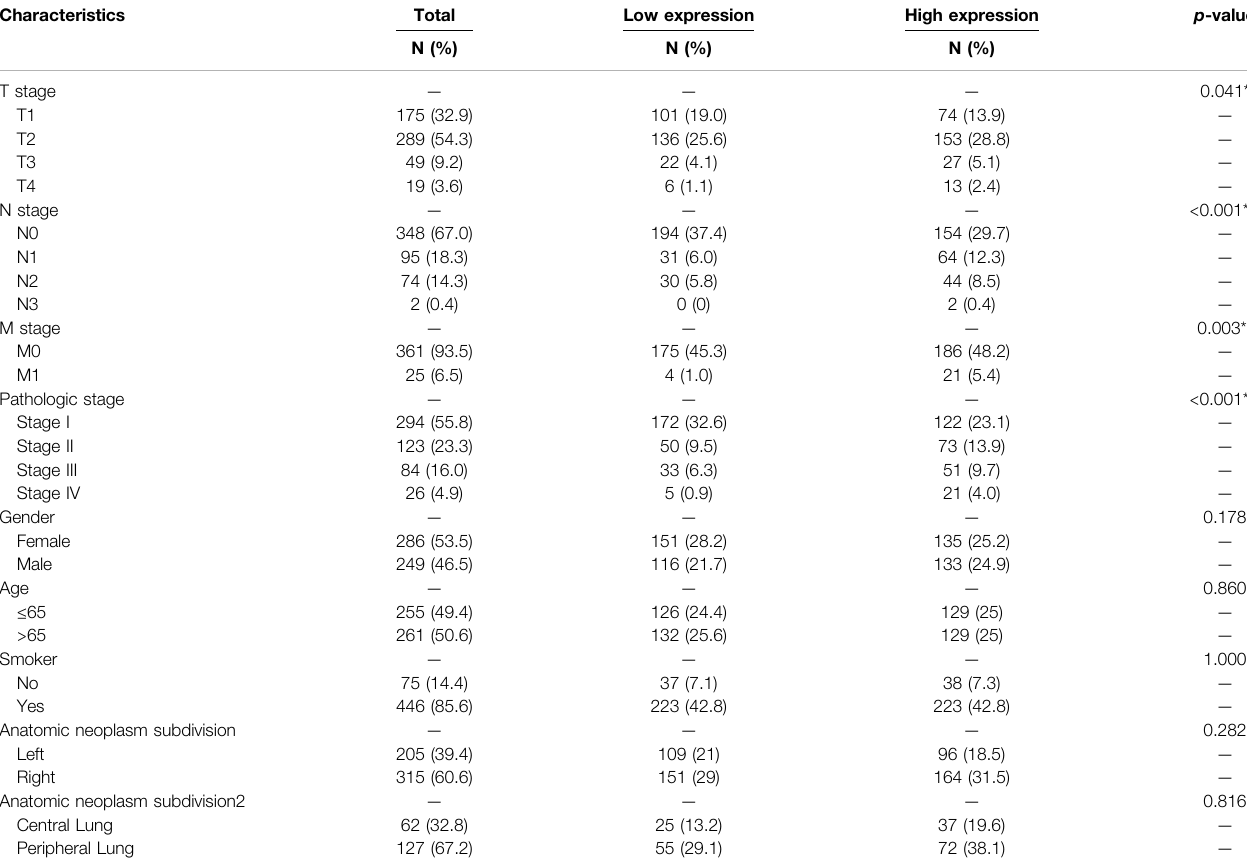
TABLE 1 | The clinicopathological characteristics of lung adenocarcinoma patients.